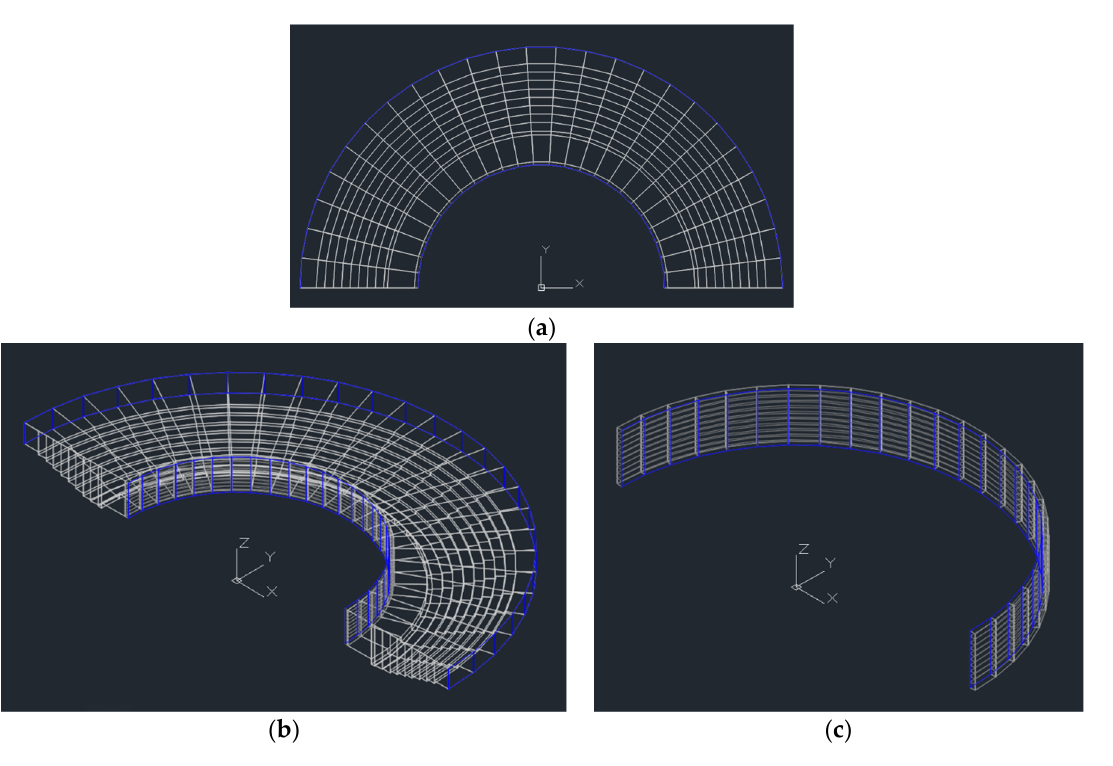
Figure 12. Virtual auditorium developed in Case D. ( a ) Top view of the auditorium and the semi- circular DSF, ( b ) tri-dimensional southeast view of the auditorium and the semi-circular DSF, and ( c ) tri-dimensional southeast view of the semi-circular DSF.